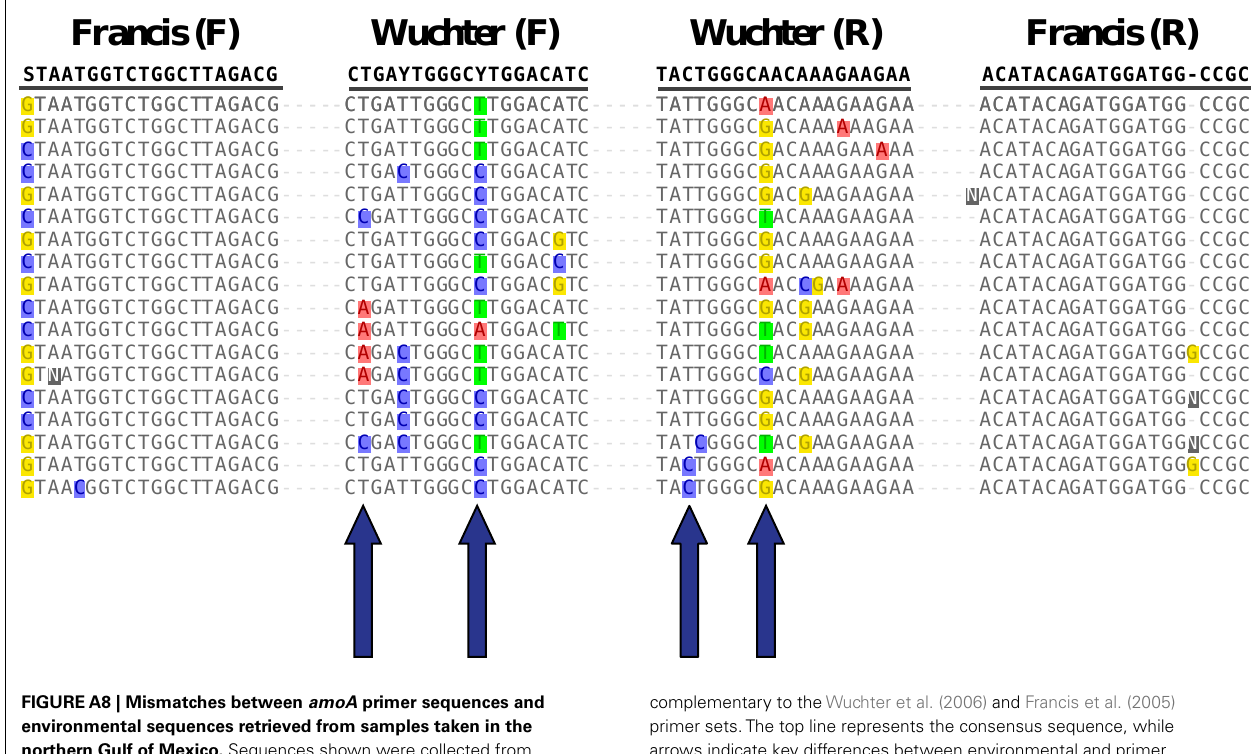
FIGUREA8 | Mismatches between amoA primer sequences and environmental sequences retrieved from samples taken in the northern Gulf of Mexico. Sequences shown were collected from Station D5, 200m depth, and were trimmed to regions